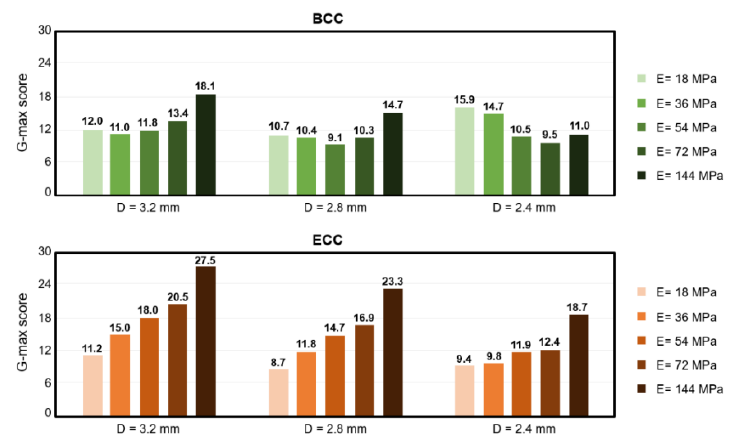
Figure 12. The comparison of the g-max score of sandwich structures with different material prop- erties.